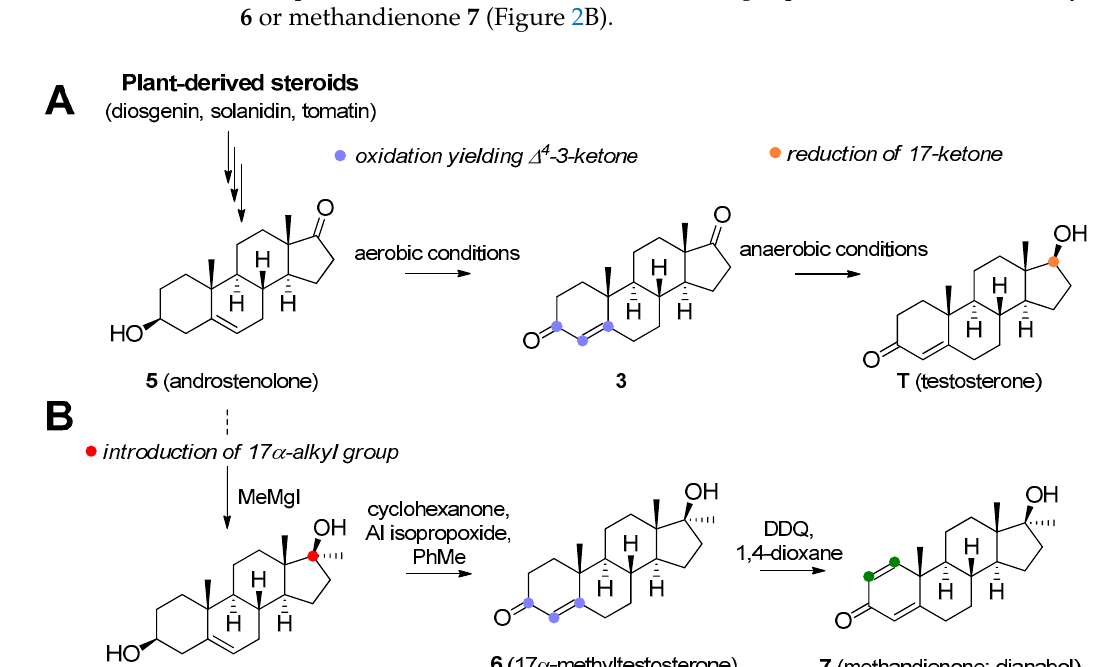
Figure 2. Microbial production of testosterone ( A ) and stereoselective introduction of alkyl (methyl) group to C 17 position ( B ).